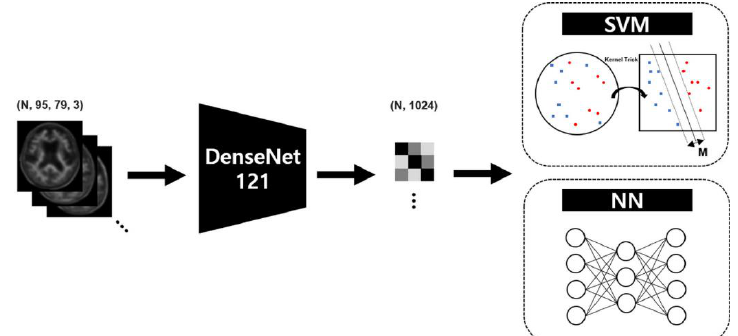
Figure 2. Target model scheme to measure the generalization performance after data augmentation based on the generative adversarial